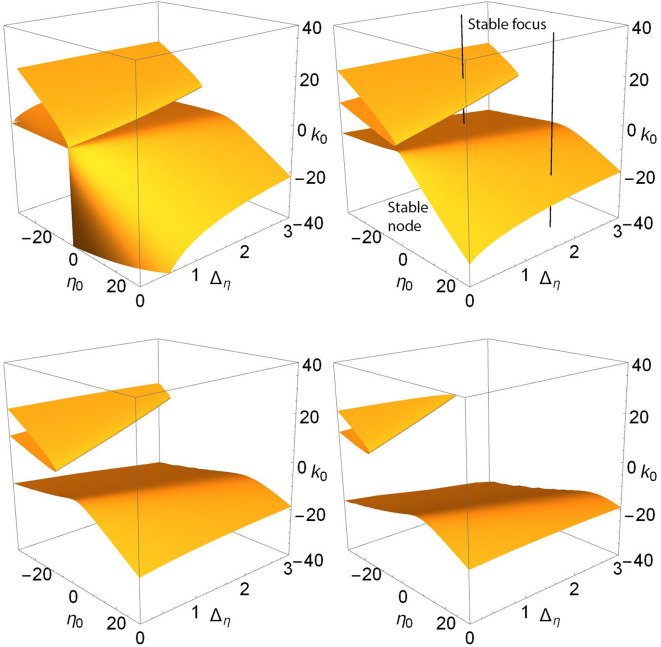
The node-focus surfaces as Δk increases. n = 2 and Δk = 0.0 (top left), 1.0 (top right), 2.0 (lower left), and 3.0 (lower right). Along the black lines in the upper right panels, we find a stable focus for k0 above the surfaces, and a stable node below; see the discussion in the text.